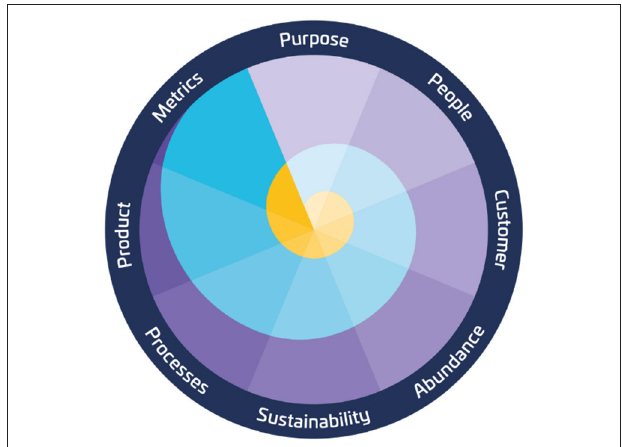
FIGURE 2 | Purpose Launchpad meta-methodology. The eight principles around which the Purpose Launchpad meta-methodology is articulated are represented: purpose, people, customer, abundance, sustainability, strategies, product, and